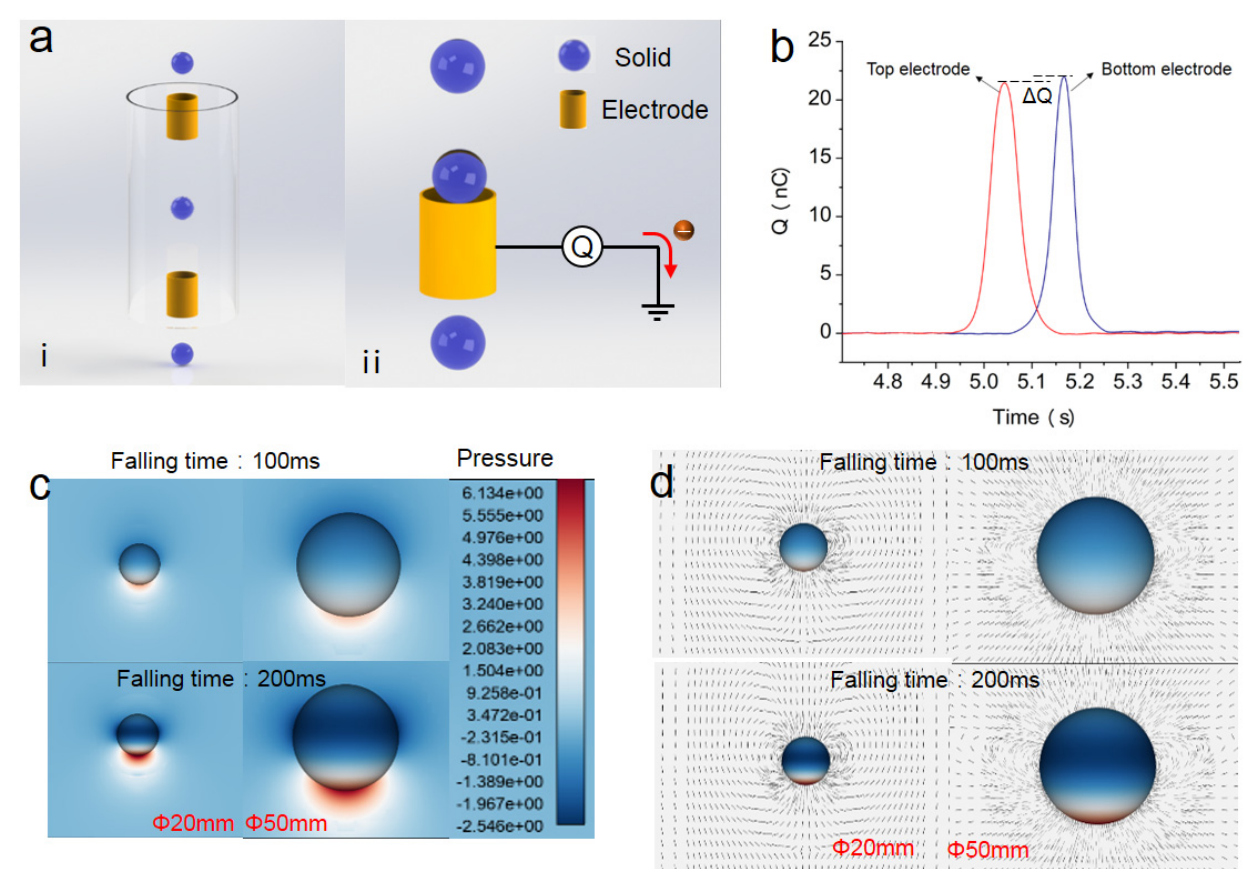
Figure 1. Experimental principle and fluid dynamics simulation. ( a ) The testing principle of gas–solid contact electrification. The device is designed based on single-electrode TENG. The solid is thrown from the top of the container in free fall, passing through the top and bottom induction electrodes, respectively. ( b ) The testing result of the top and bottom electrodes. ( c ) The change of the pressure around the solid. ( d ) The effect of surface area and speed on the distribution of gas molecules. Afterward, we systematically examined gas–solid contact electrification. Five kinds of polymer particles of polycarbonate (PC), polyamide (PA), polytetrafluoroethylene (PTFE), polyoxymethylene (POM), polypropylene (PP) with different diameters, ranging from 20 to 50 mm were selected. The gas pressure during the test was set to 101.325 kPa. They free fall from the same height above the top induction electrode, as shown in Figure 2a. Figure 2b shows the testing results of PC particles. It indicates that the ∆ Q increases as the diameter increases, meaning that the larger surface area of the particle will induce more transferred charge. This corresponds well with the above simulations in Figure 1c. As